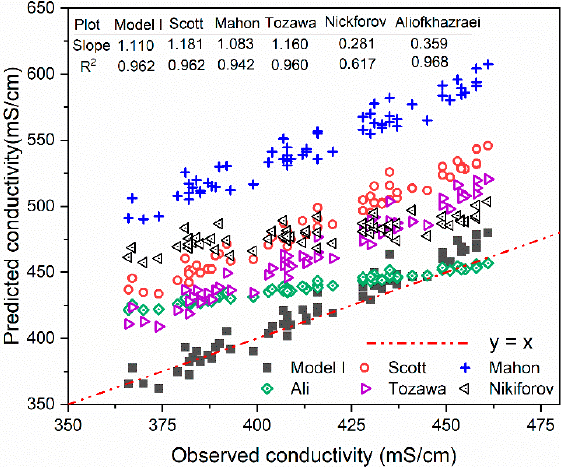
Figure 6. Measured vs. predicted conductivity for industrial Zn electrolyte determined by the